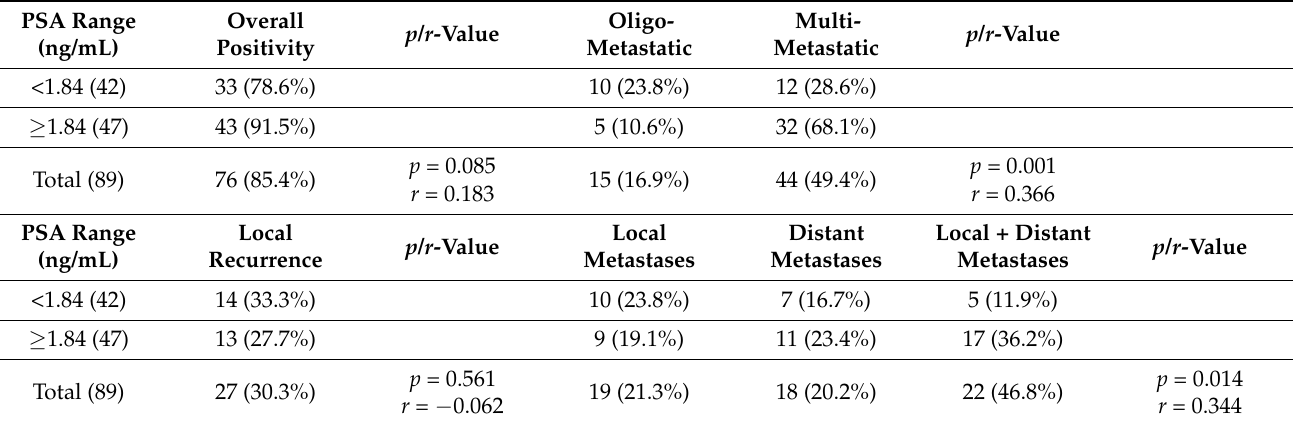
Table 8. [ 68 Ga]Ga-PSMA-11 PET/CT in 89 patients initially treated with radical prostatectomy (Ga- RP): subgroups of patients according to the number of PSMA-positive lesions categorized by pre-scan threshold 1.84